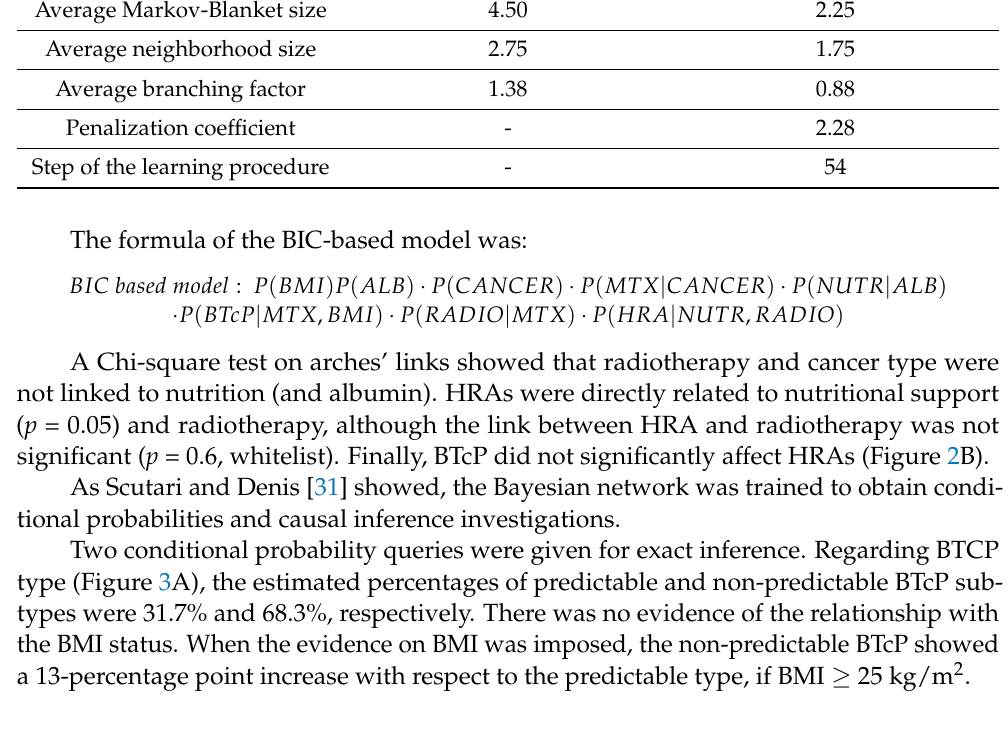
Table 4. Main indicators of the proposed models.